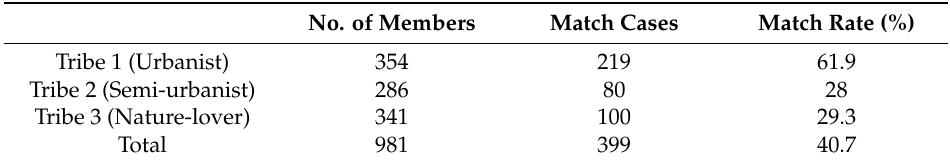
Table 3. The congruence between stated housing preferences (from survey) and revealed preferences derived from urban structural